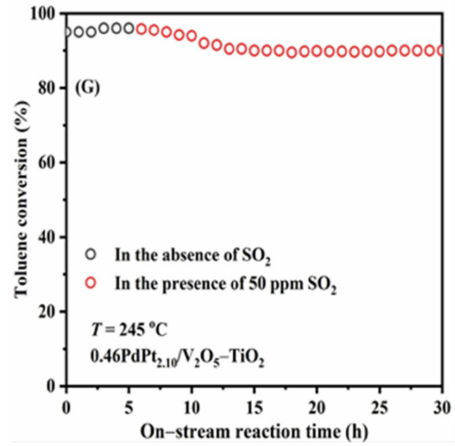
Figure 4. Effects of ( A ) 5.0 vol% H 2 O and ( B ) 5.0 vol% CO 2 on catalytic activity of 0.46PdPt 2.10 /V 2 O 5 - TiO 2 ; effect of 50 ppm SO 2 on catalytic activity of ( C ) V 2 O 5 -TiO 2 , ( D ) 0.47Pt/V 2 O 5 -TiO 2 , and ( E ) 0.46PdPt 2.10 /V 2 O 5 -TiO 2 ; and catalytic activity versus on-stream reaction time in the ( F ) ab- sence or ( G ) presence of 50 ppm SO 2 over 0.46PdPt 2.10 /V 2 O 5 -TiO 2 for toluene oxidation at an SV of 40,000 mL/(g